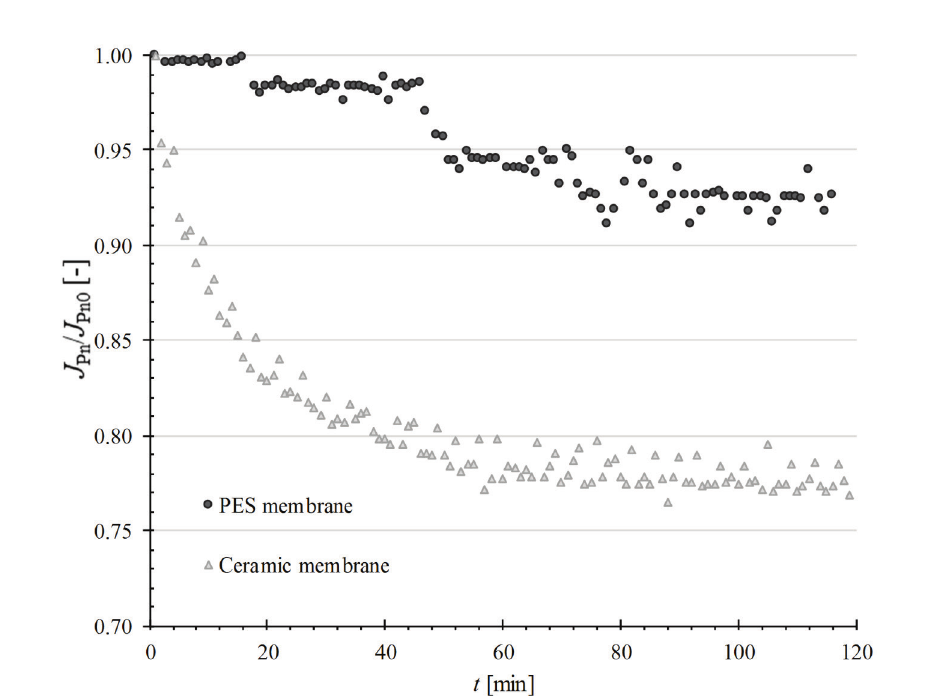
Fig. 5 – Evolution of the normalized permeate flux of textile wastewater with ceramic (cross flow velocity (CFV) 2 m s –1 , 2 bar) and polyethersulfone (PES) mem­ brane (cross flow velocity (CFV) 0.32 m s –1 , 3.5 bar), and initial permeate